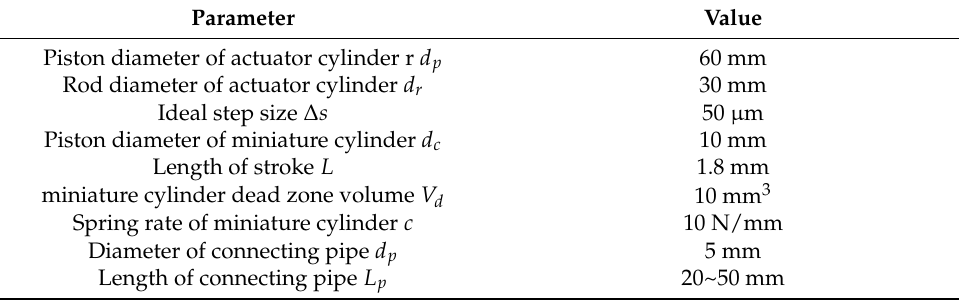
Table 2. Criterion and constraints for the hydraulic stepper drive.